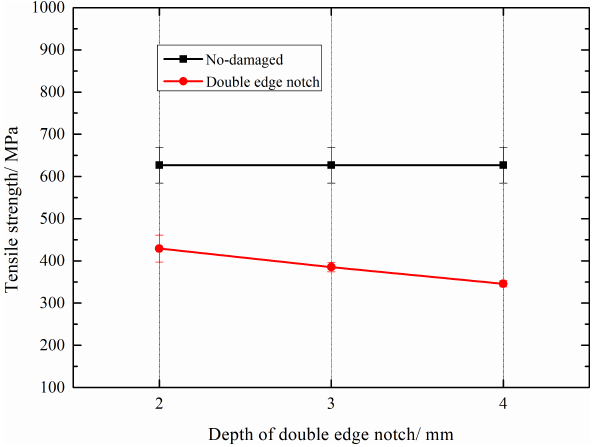
Figure 3: Comparison of static testing result on specimens with different depth of double-edge notch